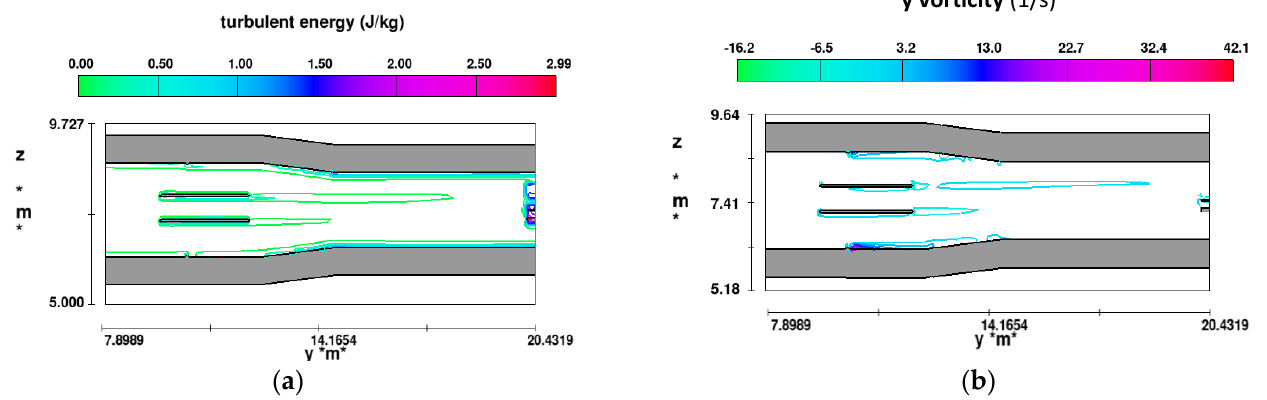
Figure 11. ( a ) sectional view of turbulent energy contours for the longitudinal distance between two valves = 4D; and ( b ) Vorticity contours.